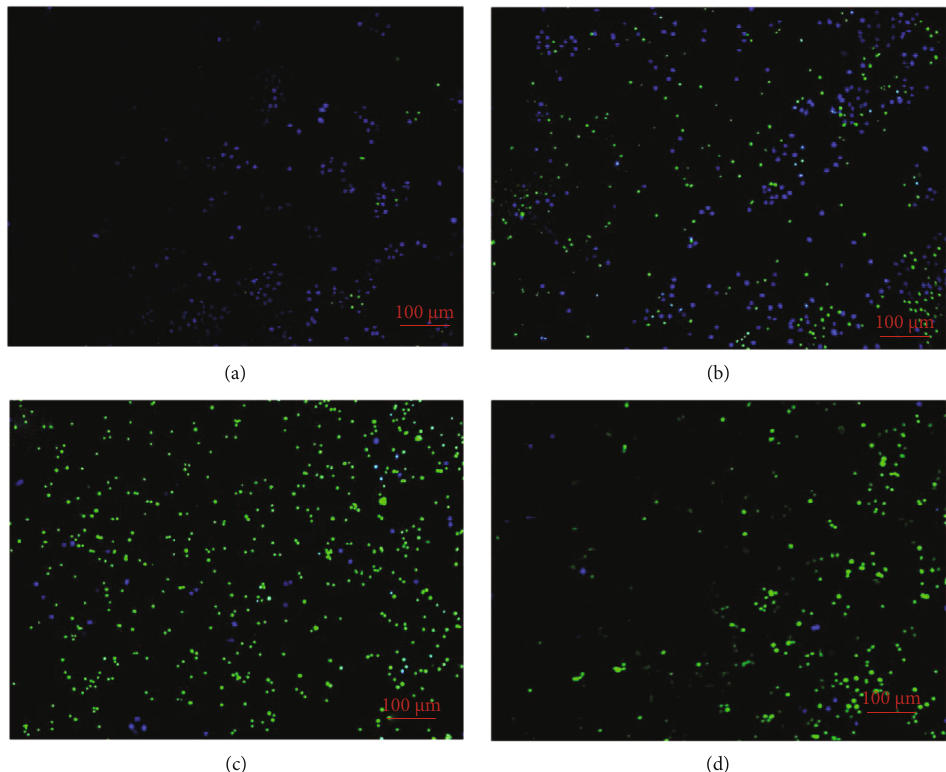
Figure 9: LIVE/DEAD assay for fi lms: (a) PHBV fi lm; (b) OZ-F, 0.008% of OZ; (c) OZ-F, 0.016% of OZ; (d) OZ-F, 0.024% of OZ. Blue =live cells; green =dead